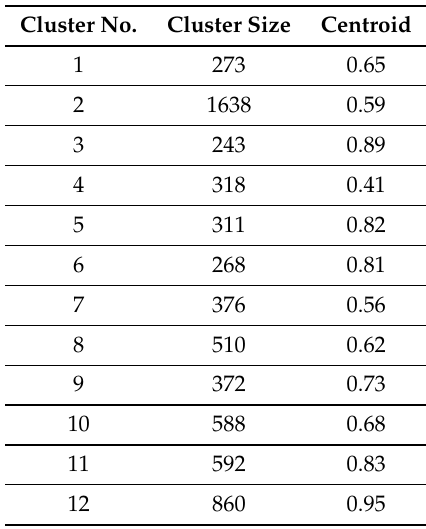
Table 1. The malware clusters for k = 12.